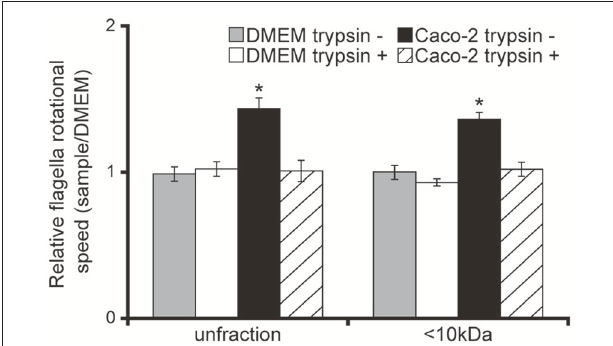
FIGURE 4 | Caco-2 cell supernatant facilitates a flagellar filament rotation of the P. aeruginosa PAO1 strain. A 15-day Caco-2 cell supernatant and Dulbecco’s modified Eagle medium (DMEM; control) were filtered through 10-kDa MW cut-off membranes. The < 10 kDa fraction or unfiltered samples were treated with or without trypsin (trypsin + or − ). P. aeruginosa PAO1 strain cells treated with the various samples were loaded onto a glass slide precoated with flagellar filament FliC antibodies. Bacterial cells were visualized and recorded as a movie using EVOS microscope, showing videos of tethered bacteria. The rotational speed was calculated from the number of rotations in 60s. Error bars indicate standard error ( n = 10). * P < 0.05 compared with DMEM of the same fraction size.